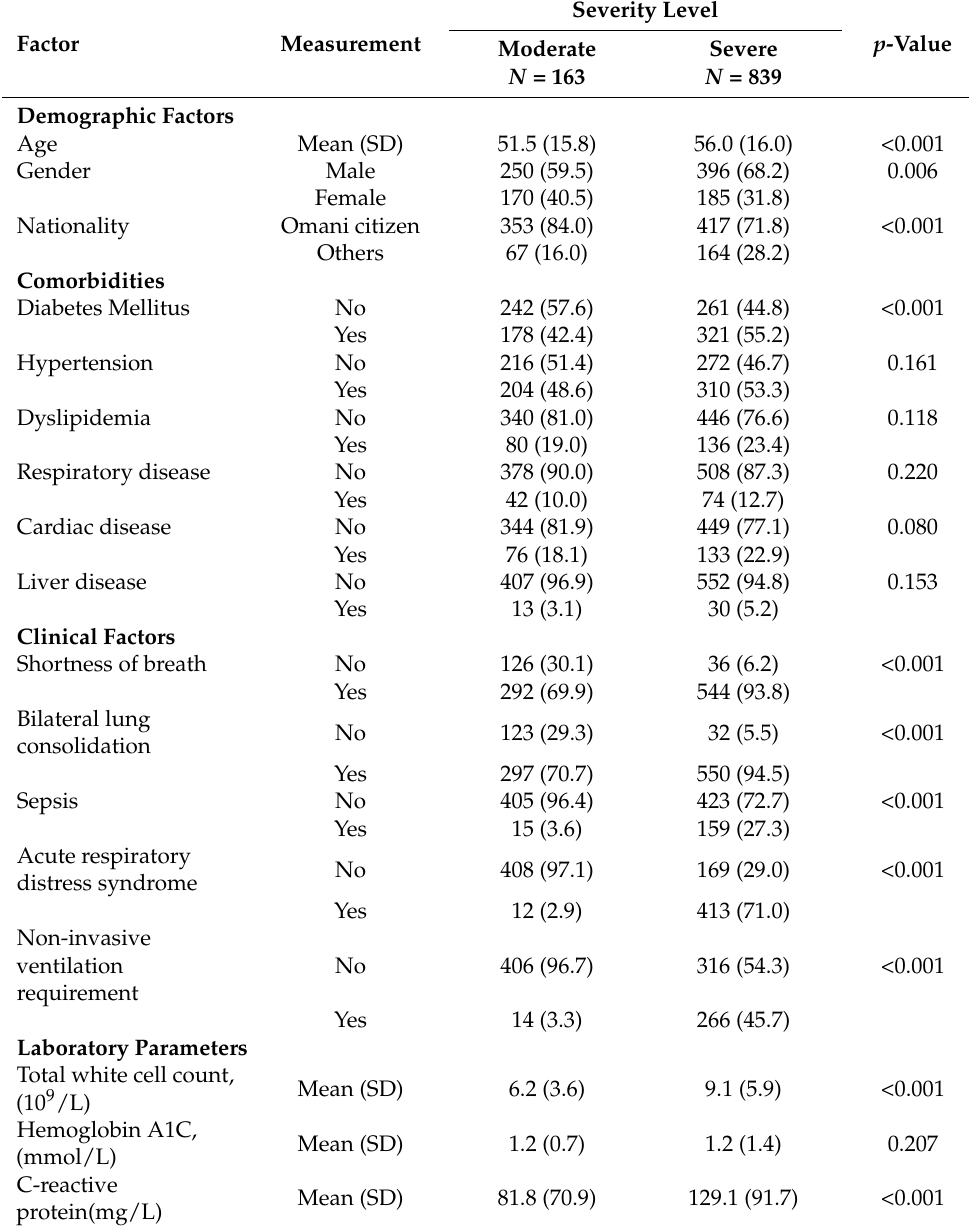
Table 2. Factors associated with severity of COVID-19 hospitalized patients ( N =